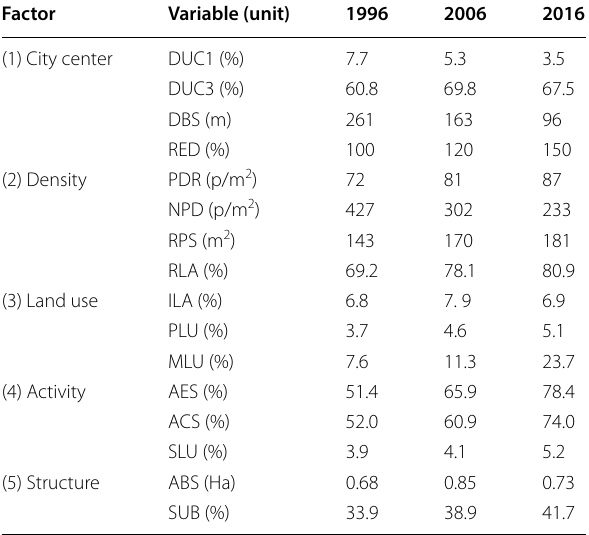
Table 4 The raw values of each variable within three temporal sequences